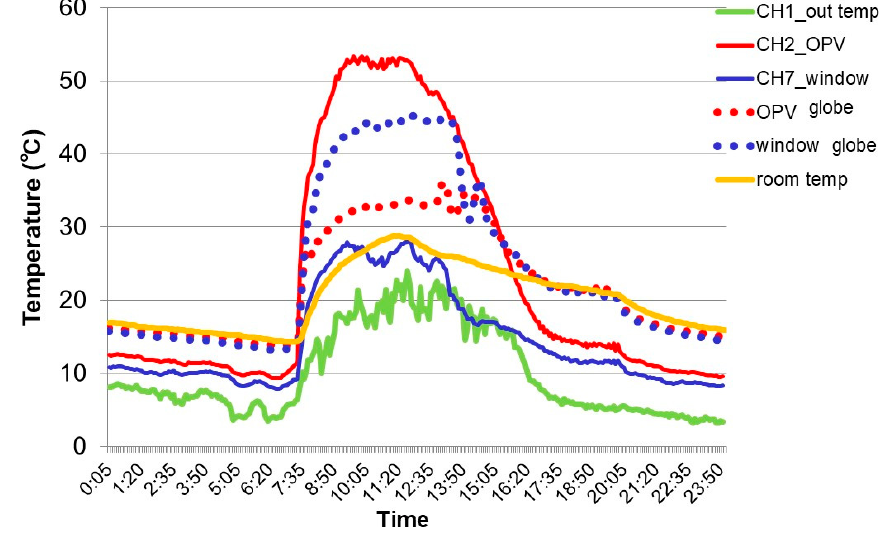
Figure 8. Thermal profile during 24 h in winter.